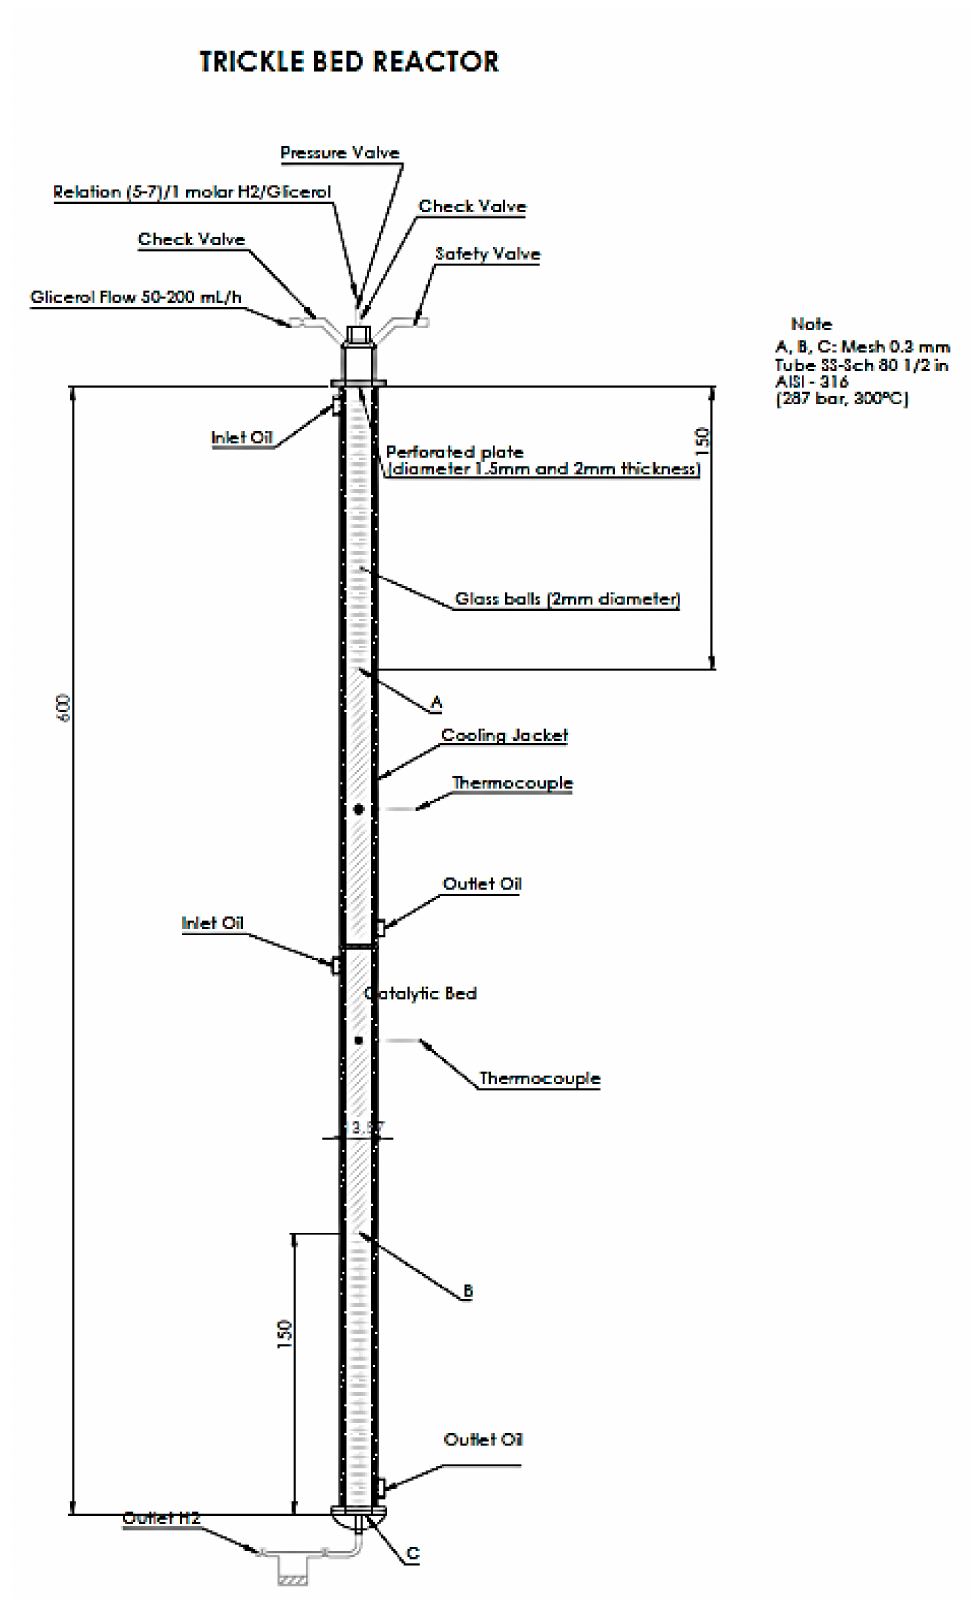
Figure 1. Trickle bed